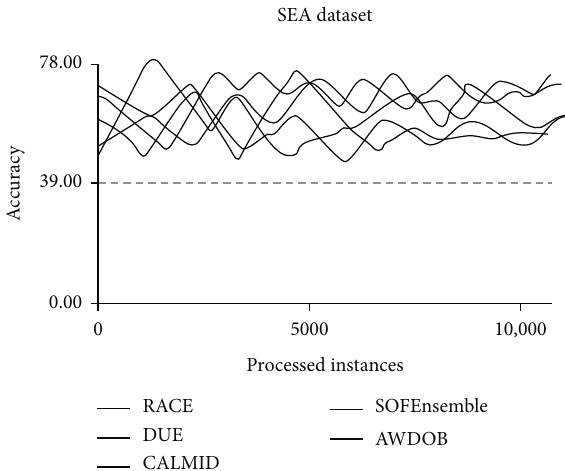
Figure 2: Prediction accuracy of the five algorithms on the Hy- perplane